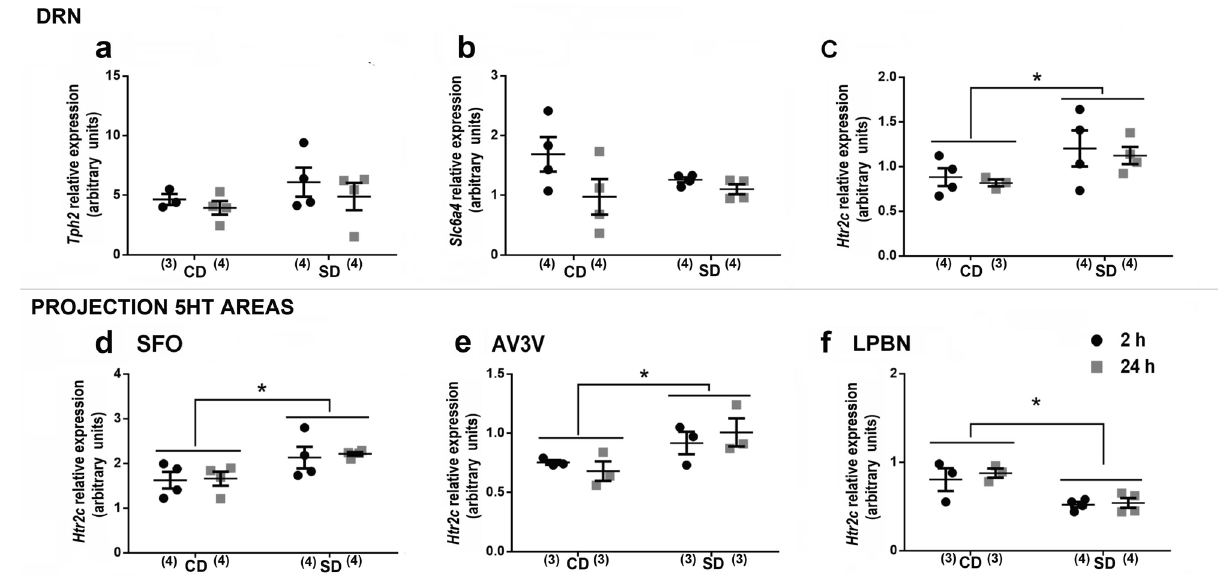
Figure 4. Brain serotonin system expression after sodium depletion. Relative mRNA level of tryptophan hydroxylase 2 ( Tph2 ), Serotonin transporter ( Slc6a4 ) and serotonin 2c receptors ( Htr2c ) in the DRN ( a , b and c , respectively), and serotonin 2c receptors ( Htr2c ) in SFO ( d ), AV3V ( e ) and LPBN ( f ) at two and 24 h after sodium depletion. Values are mean ± SE (number of cases indicated by the individual points in each case). * p < 0.05 significant difference between SD vs. CD ( c and e ). SD: Sodium-depleted group. CD: Control group. DRN: Dorsal Raphe Nucleus. LPBN: Lateral Parabrachial Nucleus. SFO: Subfornical Organ. The relative mRNA levels of serotonin 2a receptor ( Htr2a ) in LPBN and SFO are presented in Supplementary Figure